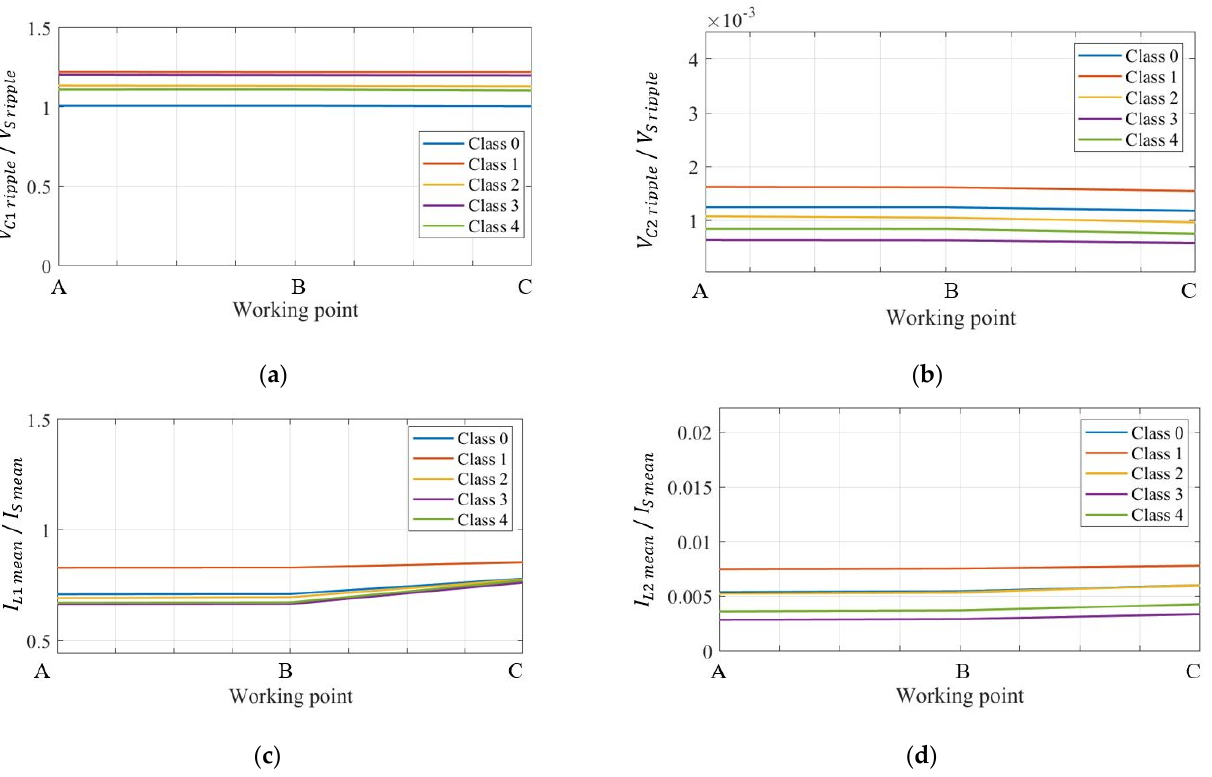
Figure 7. Sensitivity of the measurements with respect to the variation of environmental conditions; ( a ) ripple of the voltage on the first capacitor V C1ripple ; ( b ) ripple of the voltage on the second capacitor V C2ripple ; ( c ) mean value of the current through the first inductor I L1mean ; ( d ) mean value of the current through the second inductor I L2mean .